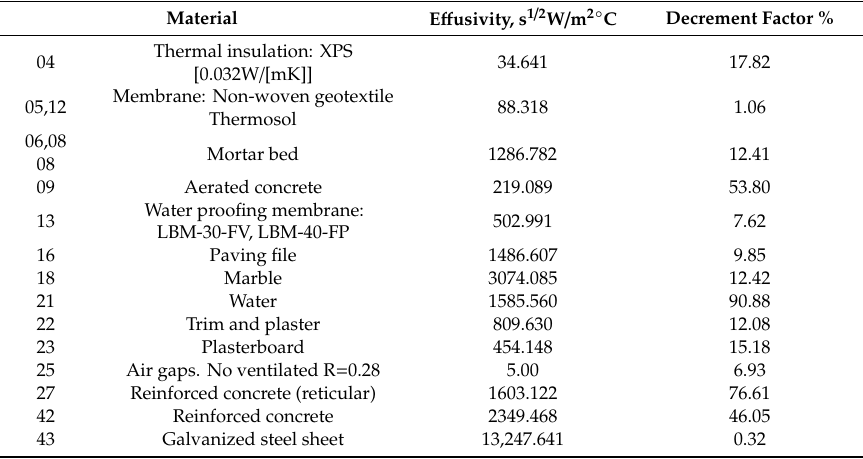
Table 10. E ff usivity and decrement factor of the materials involved in the roof